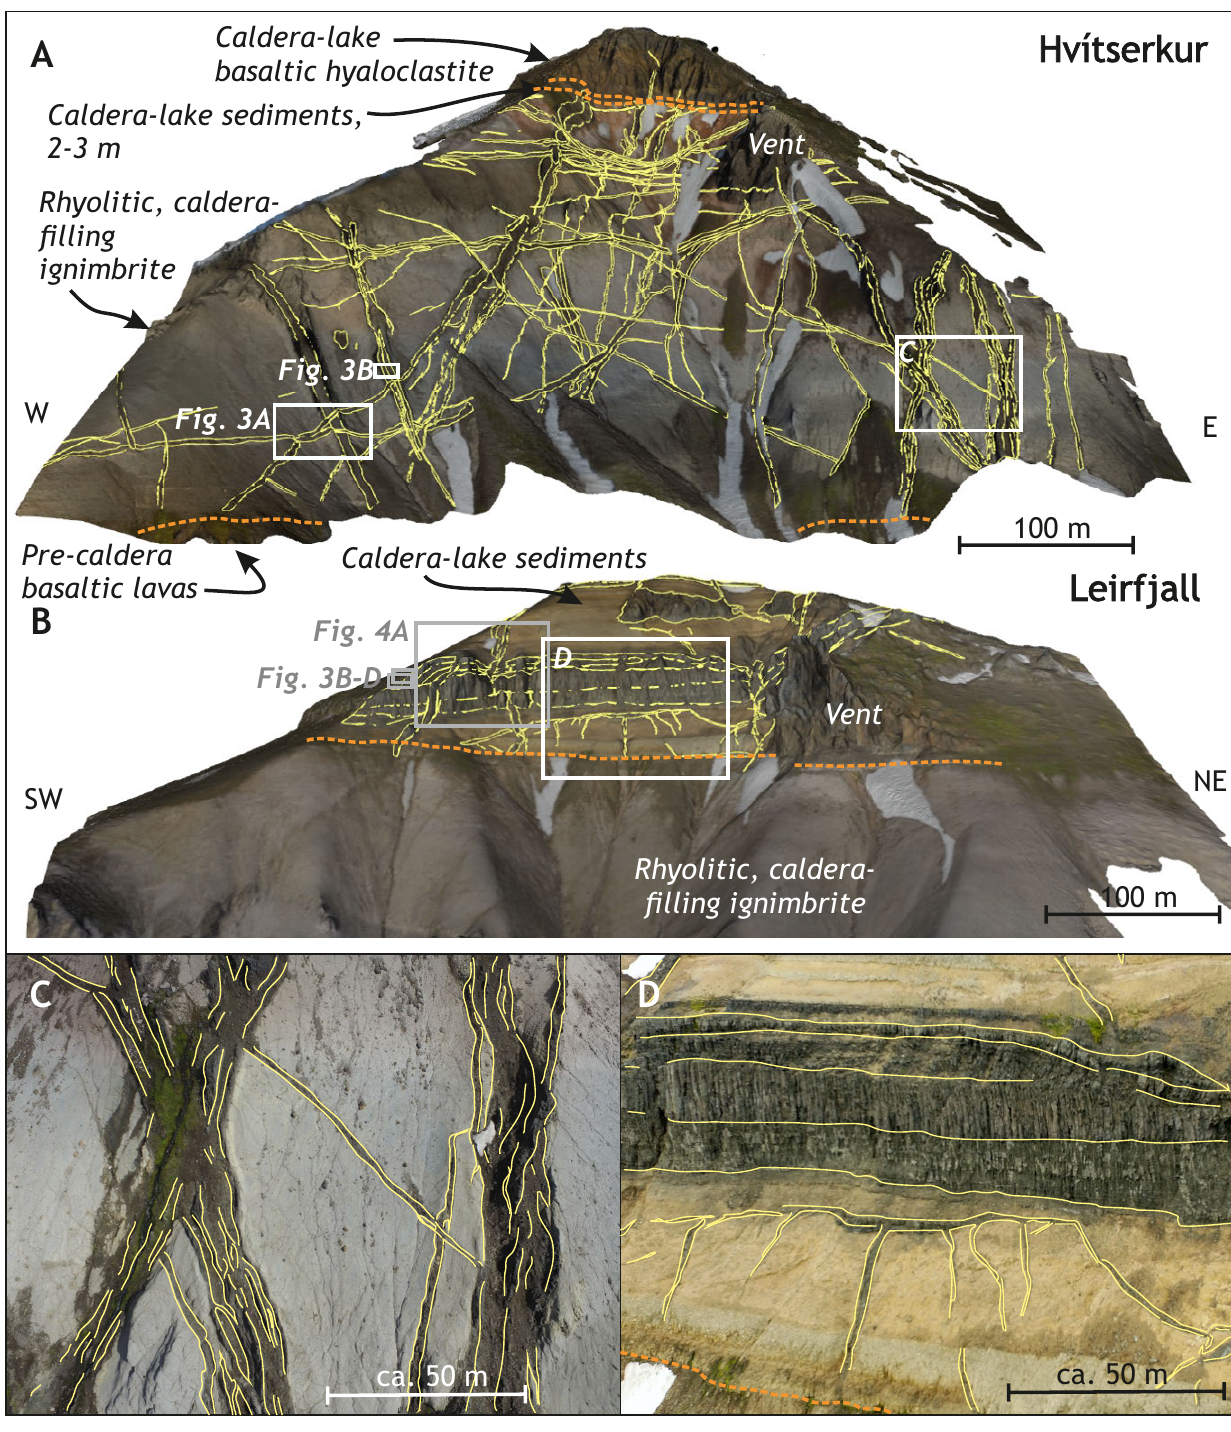
Figure 2: Virtual outcrops produced from images taken by a UAV (drone) of the mountains [A] Hvítserkur and [B] Leirfjall with stratigraphy indicated with arrows, contacts between stratigraphic units are indicated by orange dashed lines, and yellow lines outline the intrusions. This mapping was performed using the software LIME [Buckley et al. 2019]. Dykes are mostly sub-vertical, while sills are sub-horizontal. Location of photographs in this study are indicated by white/grey boxes). [C] UAV image of dykes in ignimbrite in Hvítserkur (see location in [A]) with interpretation of the margins of individual dykes indicated by yellow lines. Note that dykes tend to either cluster or crosscut each other. [D] Drone image of intrusions in lake sediments in Leirfjall (see location in [B]) with interpretation indicated by yellow lines. Note the range of intrusion thicknesses and that the thickest sill is composed of several intrusive